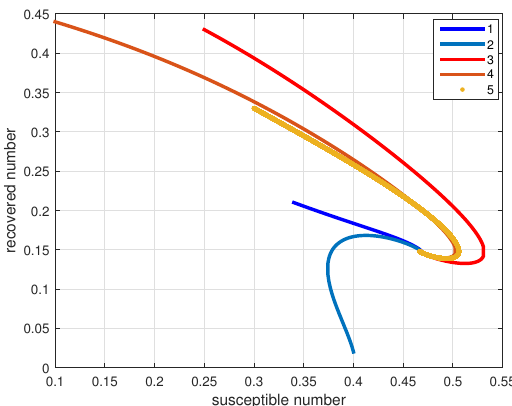
Figure 9. The phase portraits of R vs. S for system (1). The five trajectories correspond to different initial conditions and R 0 = 2.1429 > 1.